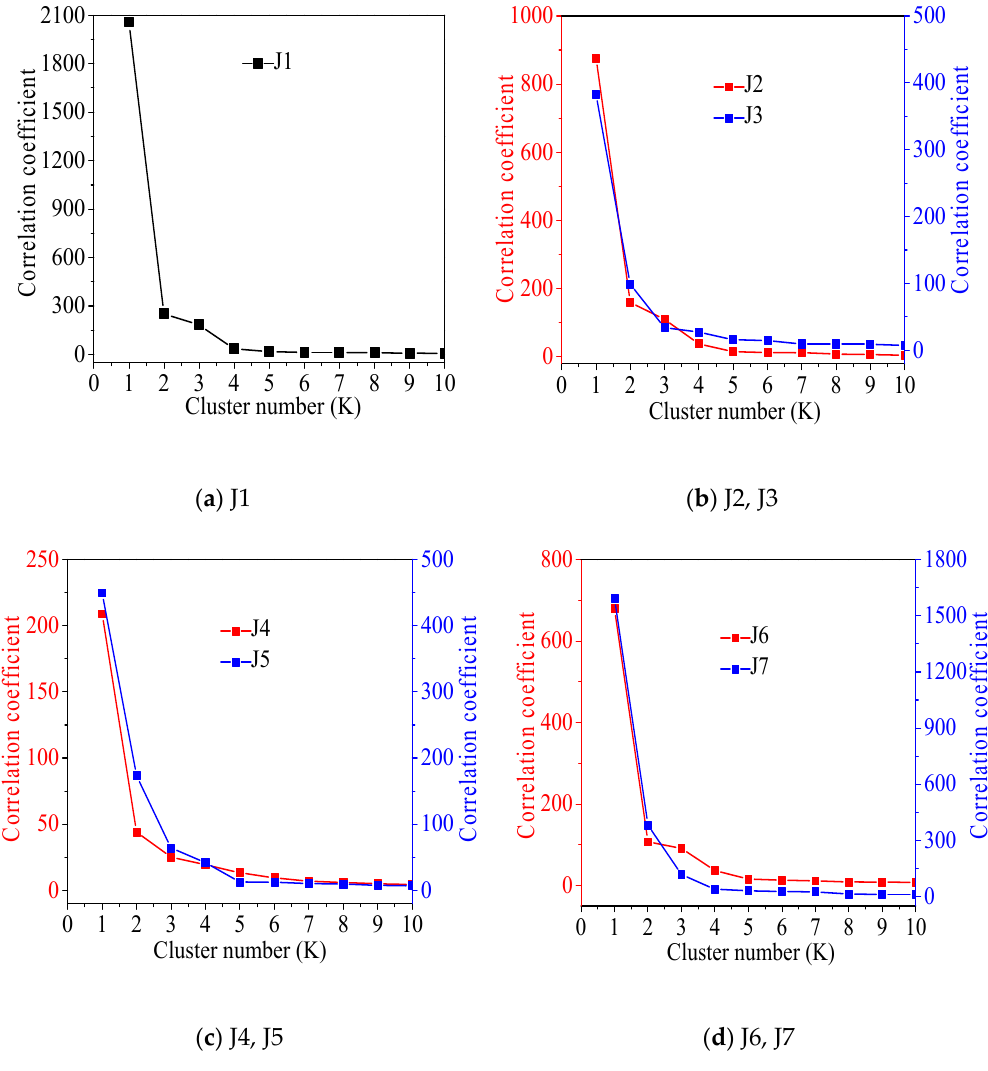
Figure 6. The optimal clustering number is determined.